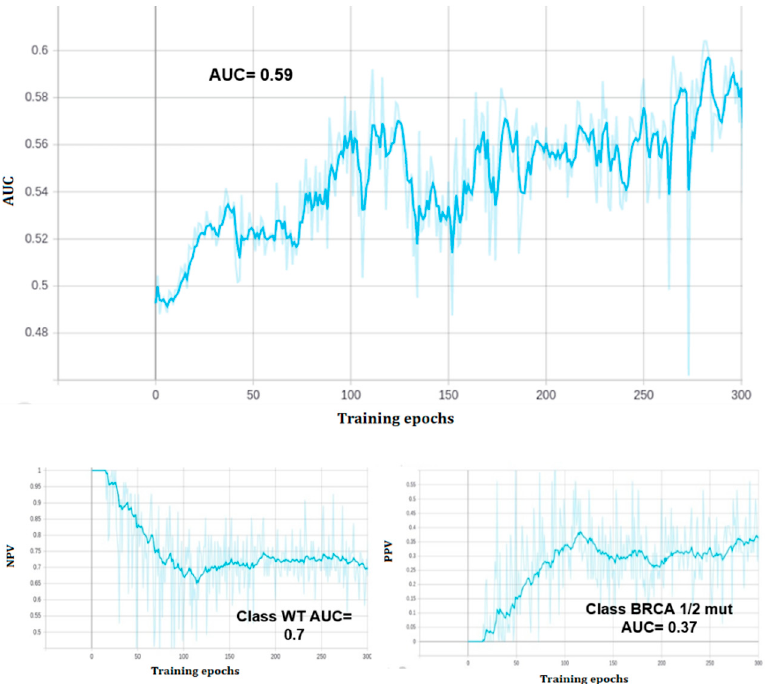
Figure 4. Phase2: Performance of the model during training (300 epochs). Top: validation AUC ROC. Low left: negative predictive value (NPV). Low right: positive predictive value (PPV).